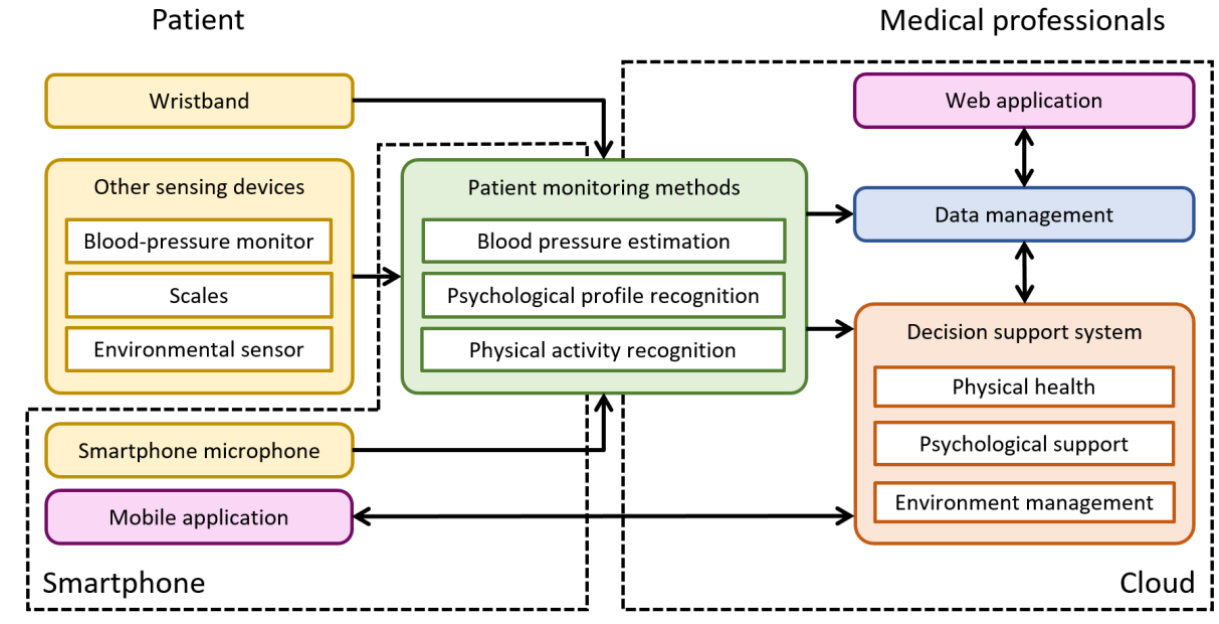
Figure 1. The logical architecture of the HeartMan